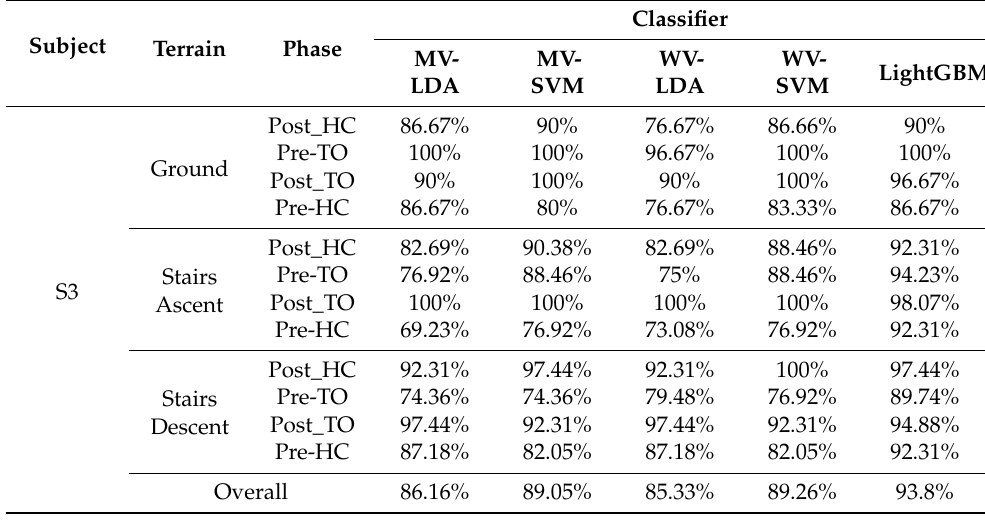
Table 6. Detailed classification performance for the five ensemble learning methods; Subject #3.